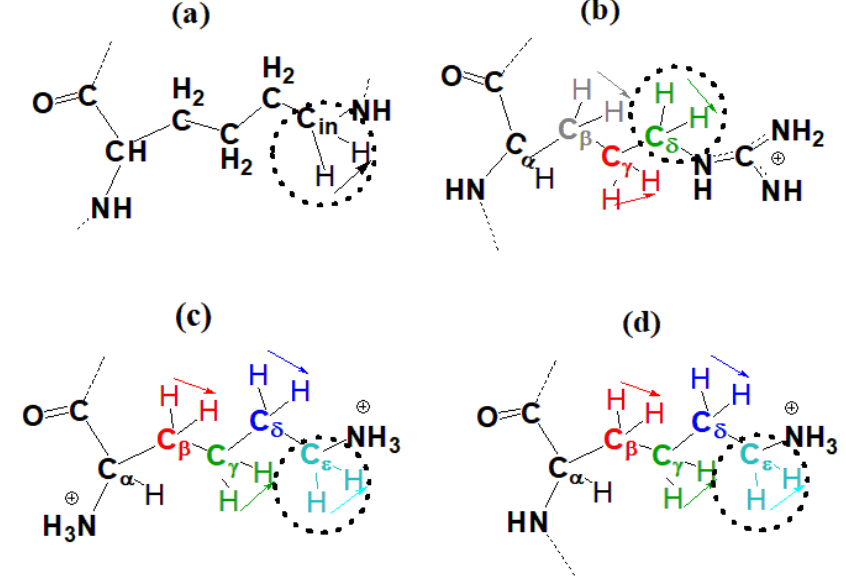
Figure 8. The structures of ( a ) inner Lys, ( b ) side Arg in spacers, and ( c ) terminal Lys segments of the Lys-2Arg dendrimer and ( d ) side Lys segment in spacers of the Lys-2Lys dendrimer. The side CH 2 groups located at different distance from the ends of the side segments of Lys-2Arg ( b ) and Lys-2Lys ( d ) are marked by different colors: at the distance (contour length) equal to the length of one chemical bond from the end—by blue color, two bonds—by navy, three bonds—by green, four bonds—by red, five bonds—by